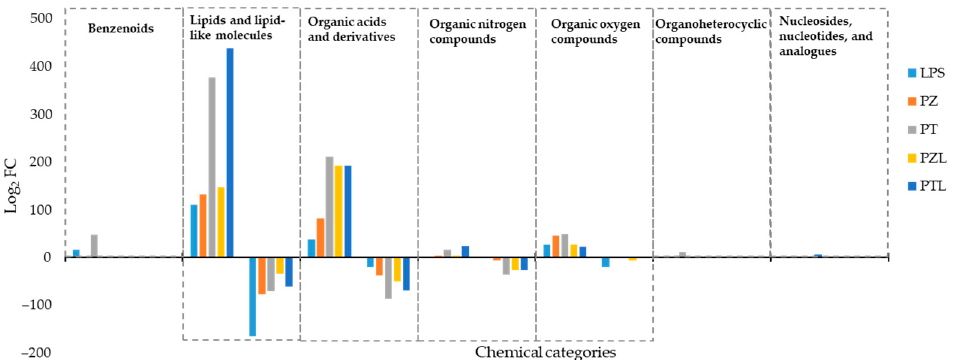
Figure 2. Specific chemical categories of dysregulated entities in the evaluated conditions (LPS, lipopolysaccharide; PZ, phlorizin; PT, phloretin, PZL, phlorizin + LPS; PTL, phloretin + LPS) compared to untreated THP-1 differentiated macrophages (BASAL). Increased and decreased entities were indicated by the fold change (FC > 2.0) and were also adjusted to p -values < 0.05.